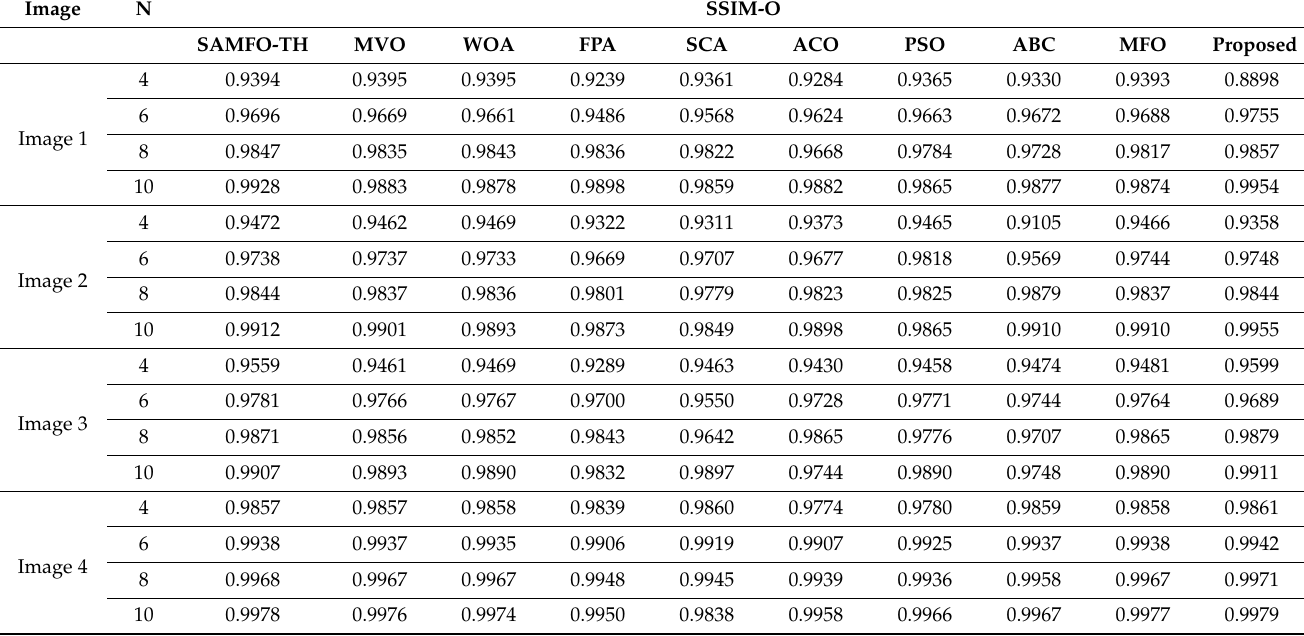
Table 11. Comparison of SSIM computed by SAMFO-TH, MVO, WOA, FPA, SCA, ACO, PSO, ABC, and MFO with the proposed model using Otsu’s method with N = 4, 6, 8, and